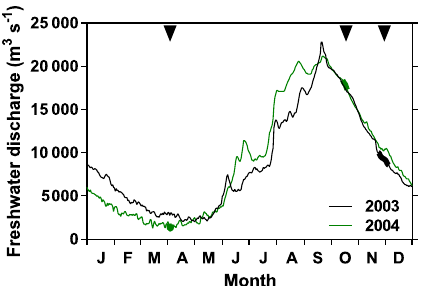
Figure 2. Seasonal evolution of daily freshwater discharge in the Mekong River at Tân Châu in 2003 and 2004. Thick lines and black triangles indicate the three sampling